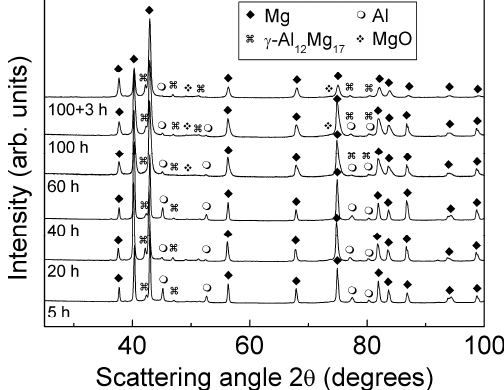
Figure 3. XRD patterns (Co-K different periods.